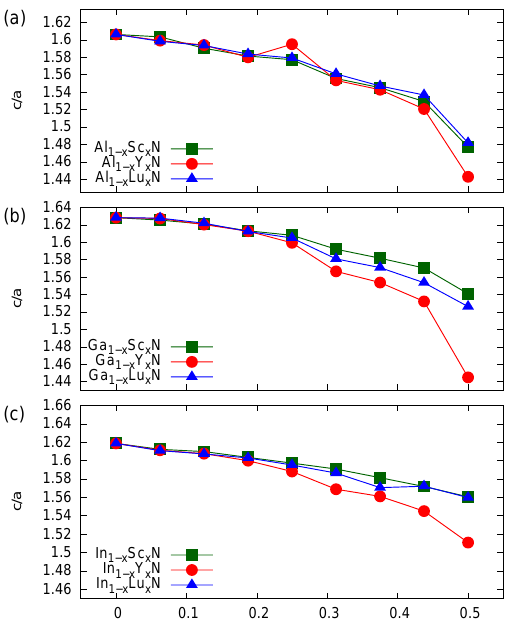
Figure 2. The values of c/a ratio calculated (GGA) for wurtzite alloys ( a ) Al 1 − x RE x N, ( b ) Ga 1 − x RE x N, ( c ) In 1 − x RE x N, where RE = Sc, Y, and